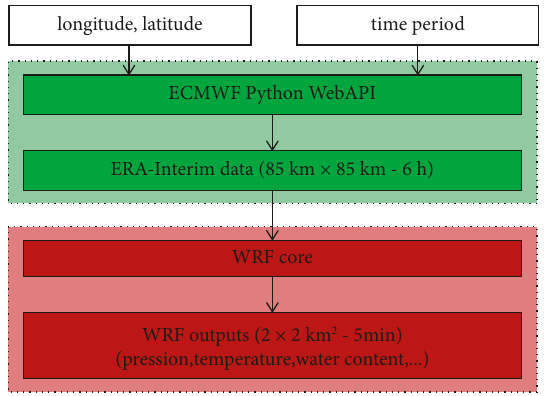
Figure 1: Block diagram of the WRF-ARW